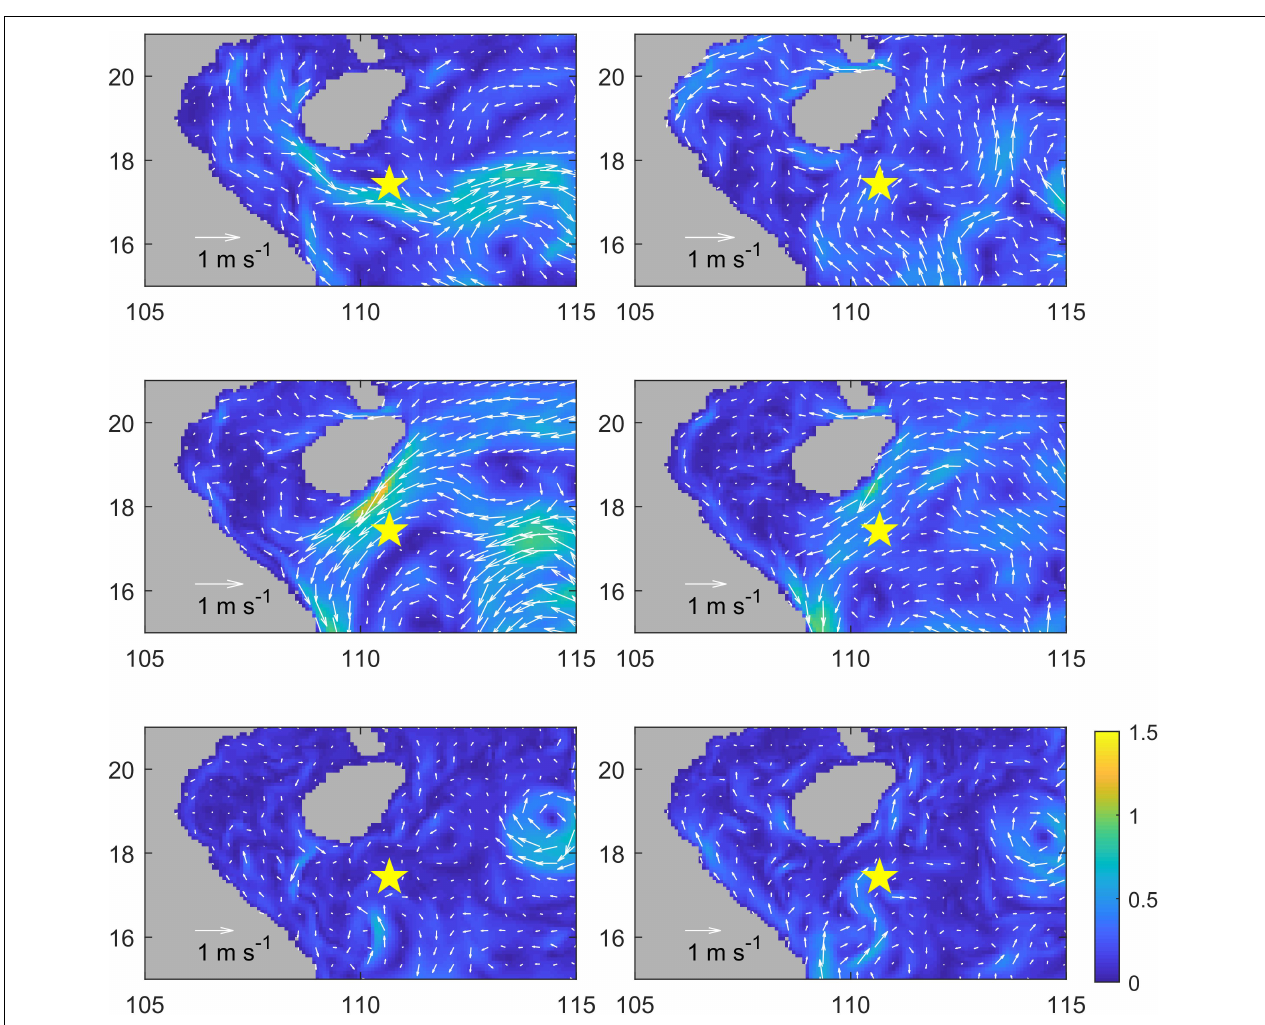
FIGURE 6 | Sea surface current field (data from the HYCOM reanalysis product) in the study area on (A) August 6, 2012, (B) September 5, 2012, (C) October 5, 2012, (D) November 19, 2012, (E) February 2, 2013, and (F) February 17,